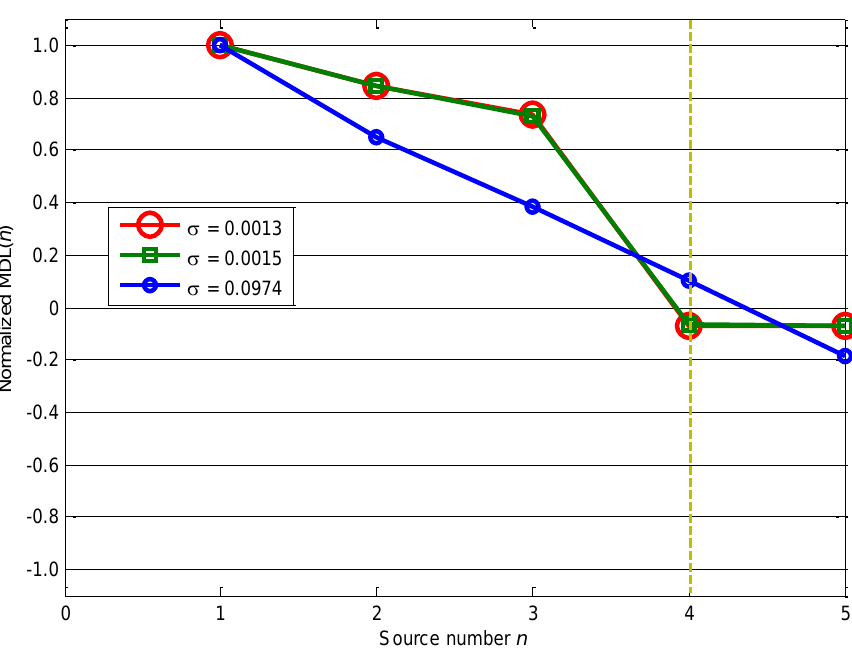
Figure 7. Source number estimation by MDL.